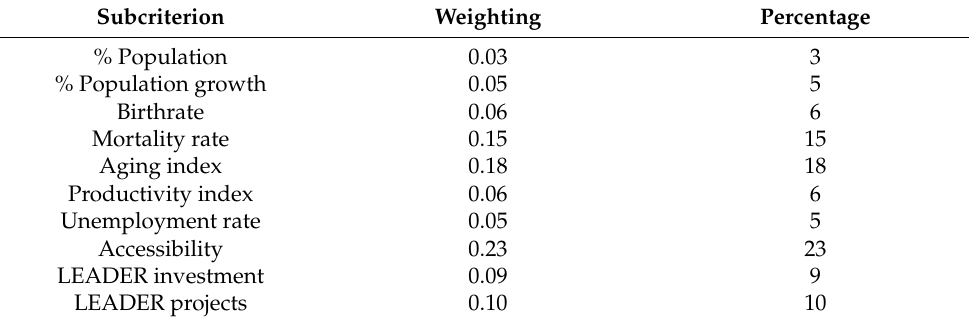
Table 6. Priority vector for subcriteria.